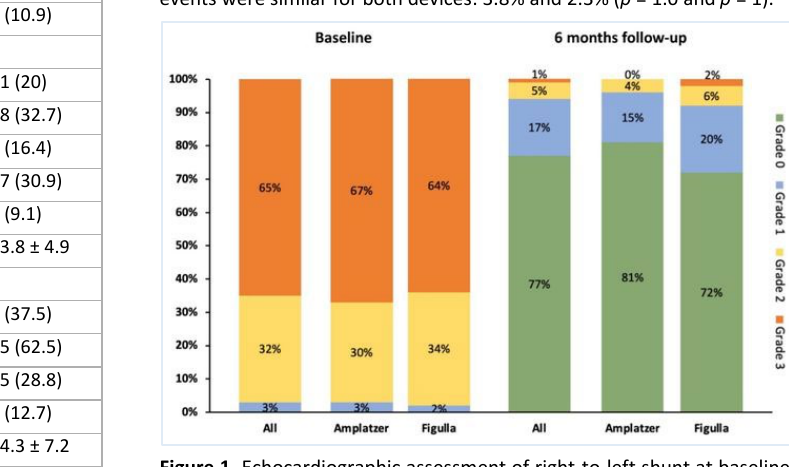
Figure 1. Echocardiographic assessment of right-to-left shunt at baseline and six-month